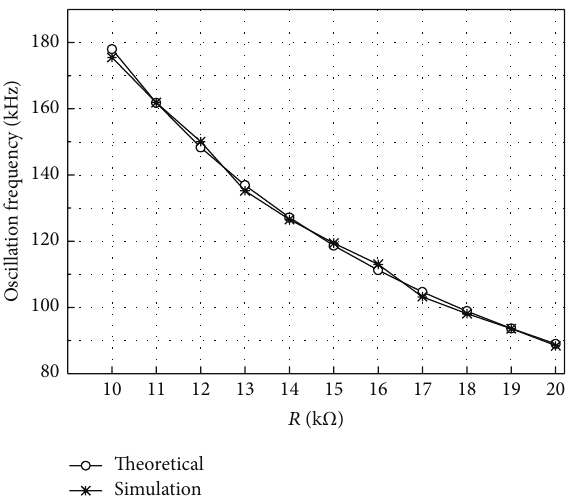
Figure 13: Variation of the oscillation frequency against 𝑅 for the circuit (Figure